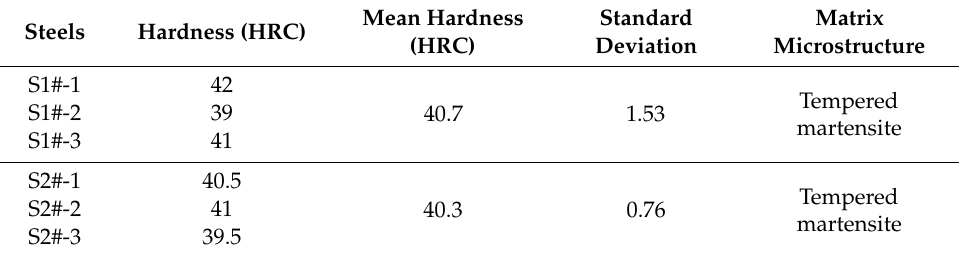
Table 3. Matrix microstructure and hardness of the 50CrVA after fatigue